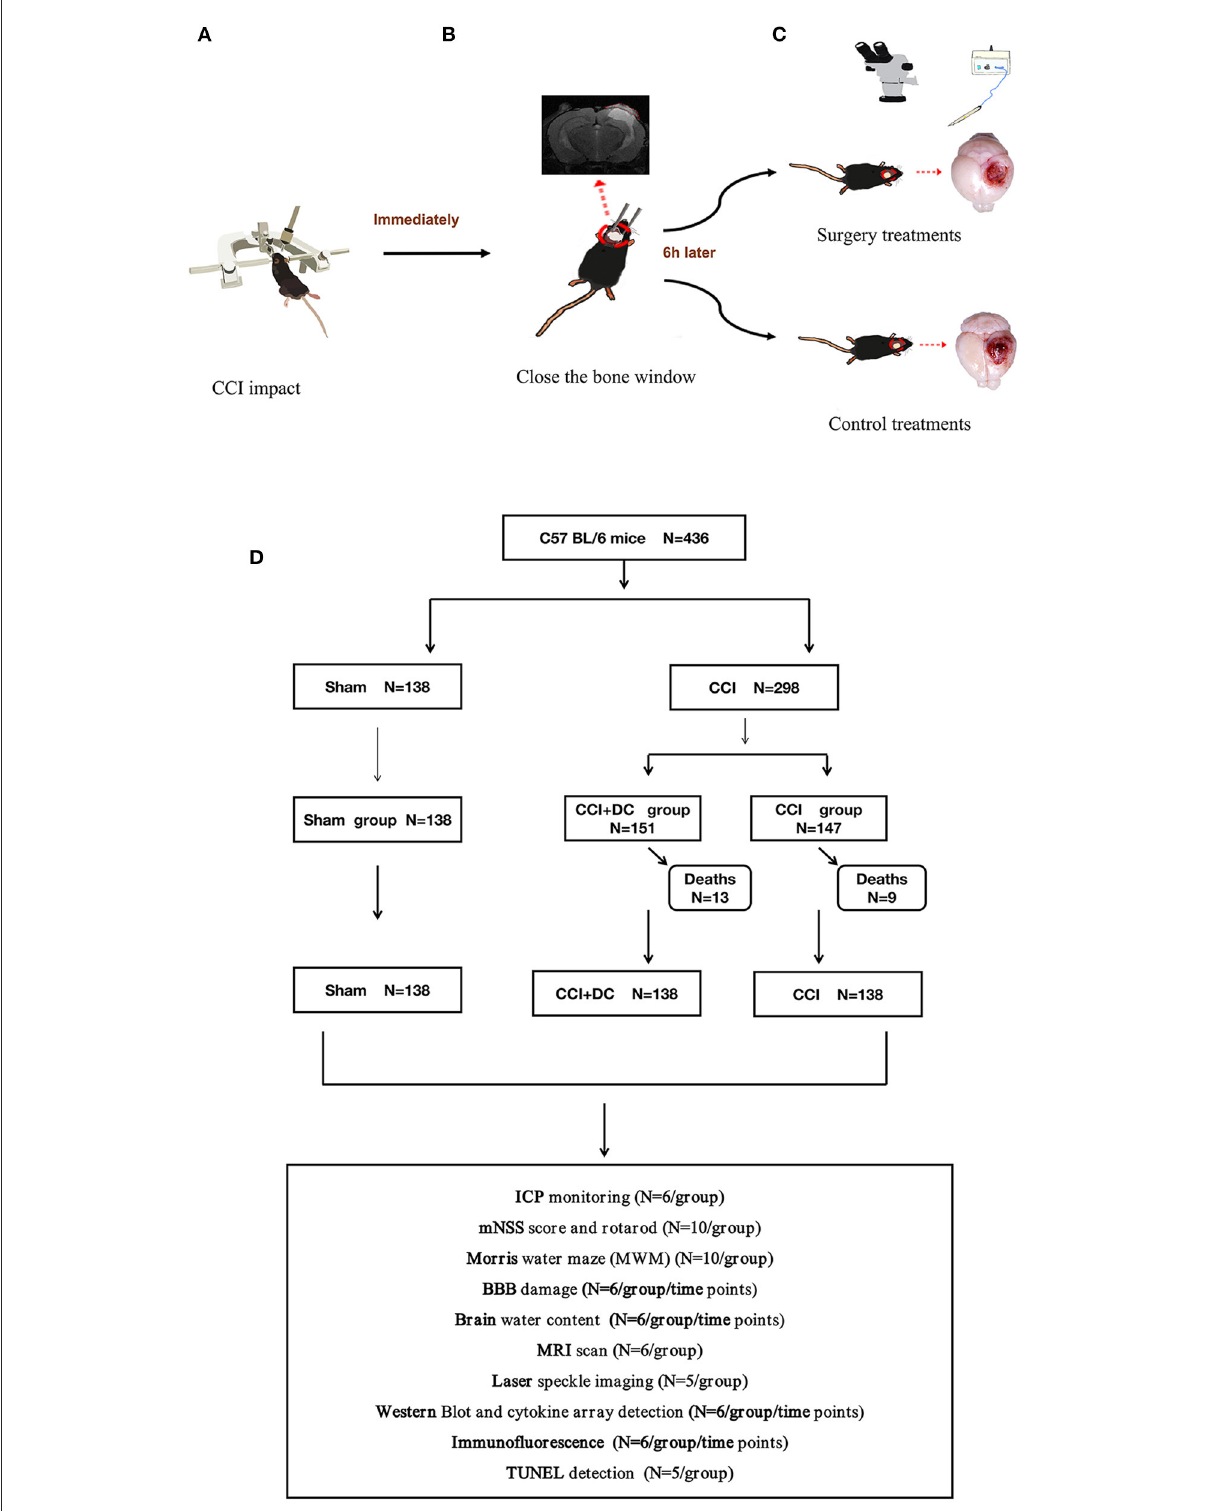
FIGURE1 Experimental flow chart. (A) Mice in the CCI + DC group and CCI group were hit by CCI. (B) After the attack, the bone window was closed immediately. (C) 6h after the attack, the mice in the CCI + DC group underwent bone window removal and contused tissue removal, the CCI group received the same anesthesia and skin incision. (D) Flow chart showing the experimental protocol with the number of animals used, died and included in the